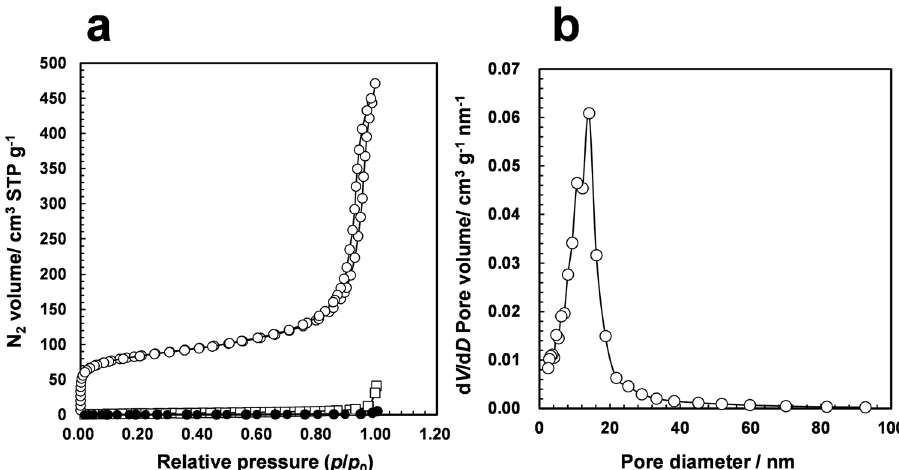
Fig. 8 BET/BJH analysis resutls. a N 2 adsorption-desorption isotherm of (open circle) recovered solid after fl uoride catalysis, (open squre) fresh silicon powder, and ( fi lled circle) recovered solid under reaction conditions without fl uoride catalyst. b BJH pore size distribution of recovered sold after the